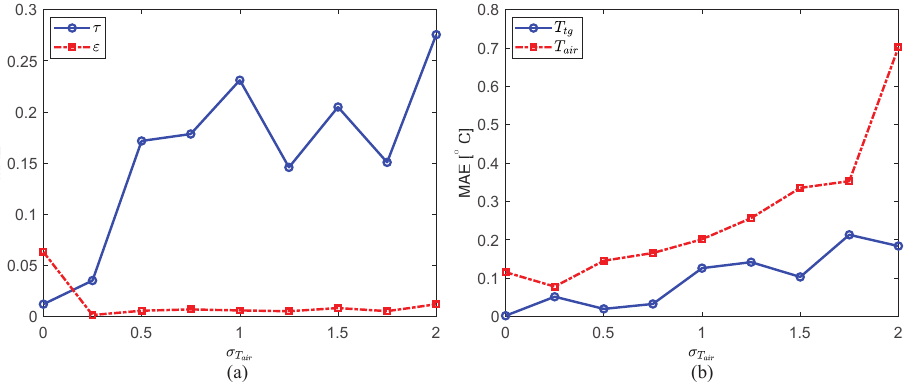
): ( a ) MAE of τ , ε , air